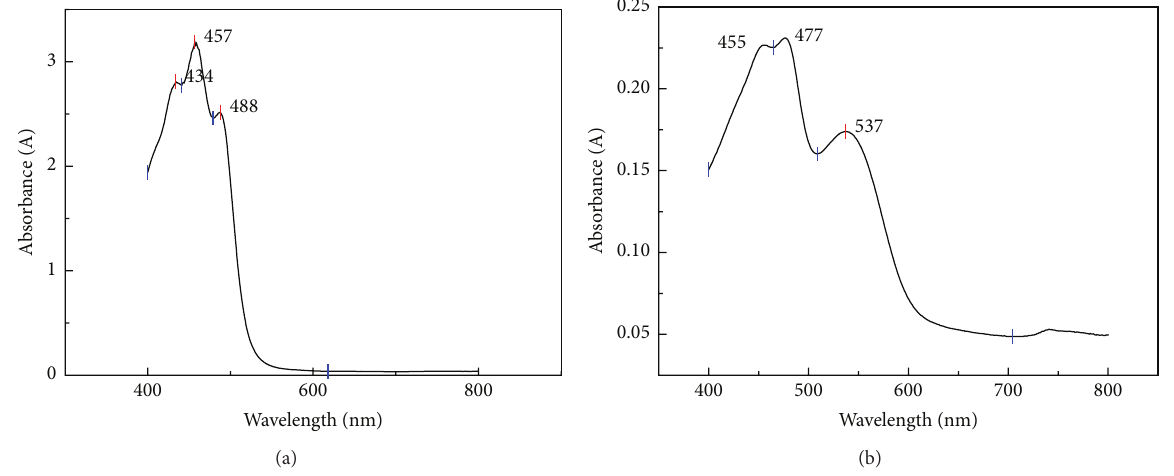
Figure 3: UV-vis spectra from (a) annatto and (b) beetroot extracts.